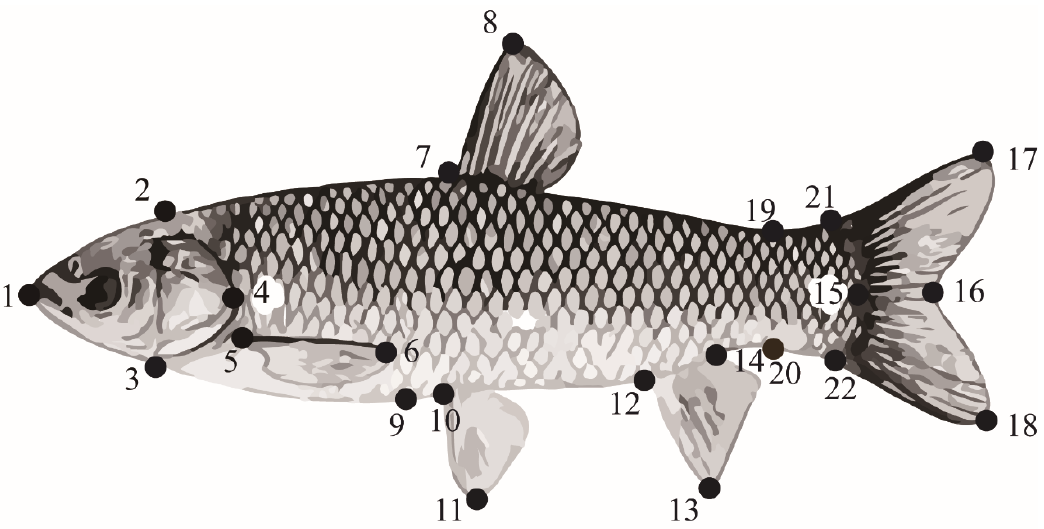
Figure 1. Data collection site diagram of physical characteristics in grass carp. Twenty-two points were set as the overall shape indicator in juvenile grass carp, as previously described in Lu [25].